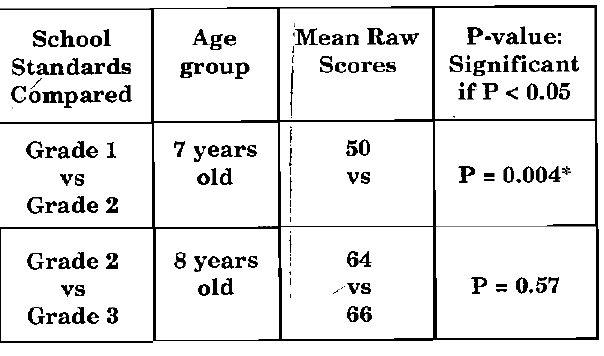
TABLE 3: Mean raw scores obtained by pupils from the same age group but different scholastic